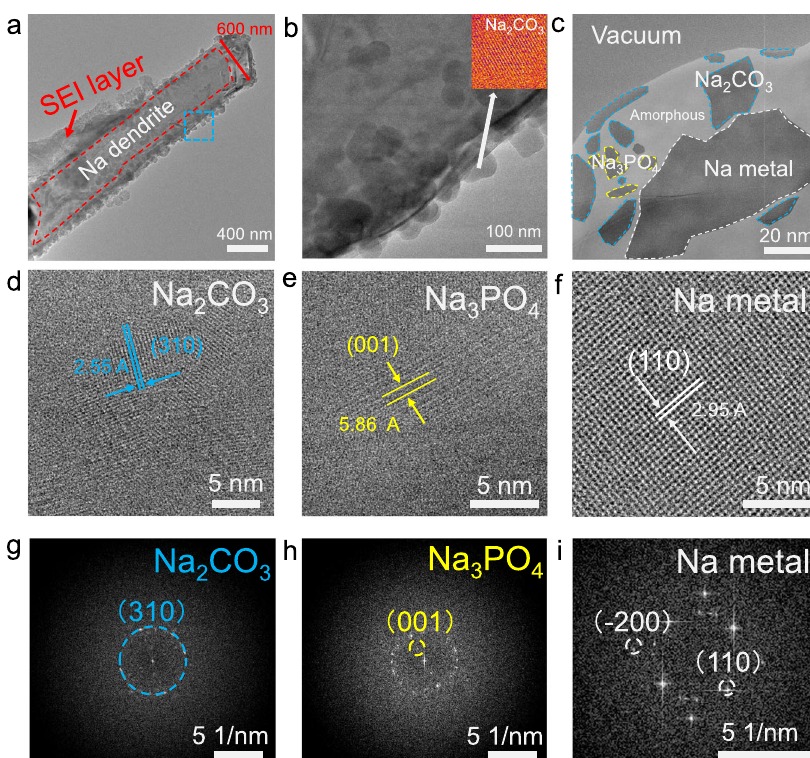
Fig. 1 Microstructure of Na-metal dendrite and SEI formed in FEC-free EC:DMC-based electrolyte at the fi rst cycle. a Cryo-TEM of the Na dendrite at a low magni fi cation. b Magni fi ed TEM of the region outlined in blue in a , with inset showing the HRTEM of the spherical Na 2 CO 3 particles. c HRTEM showing the distribution of the SEI components. d , g Representative HRTEM and FFT of Na 2 CO 3 , e , h ) Na 3 PO 4 , and f , i Na metal observed in the SEI. (The HRTEMs were obtained with an electron dosage of ~120 e Å − 2